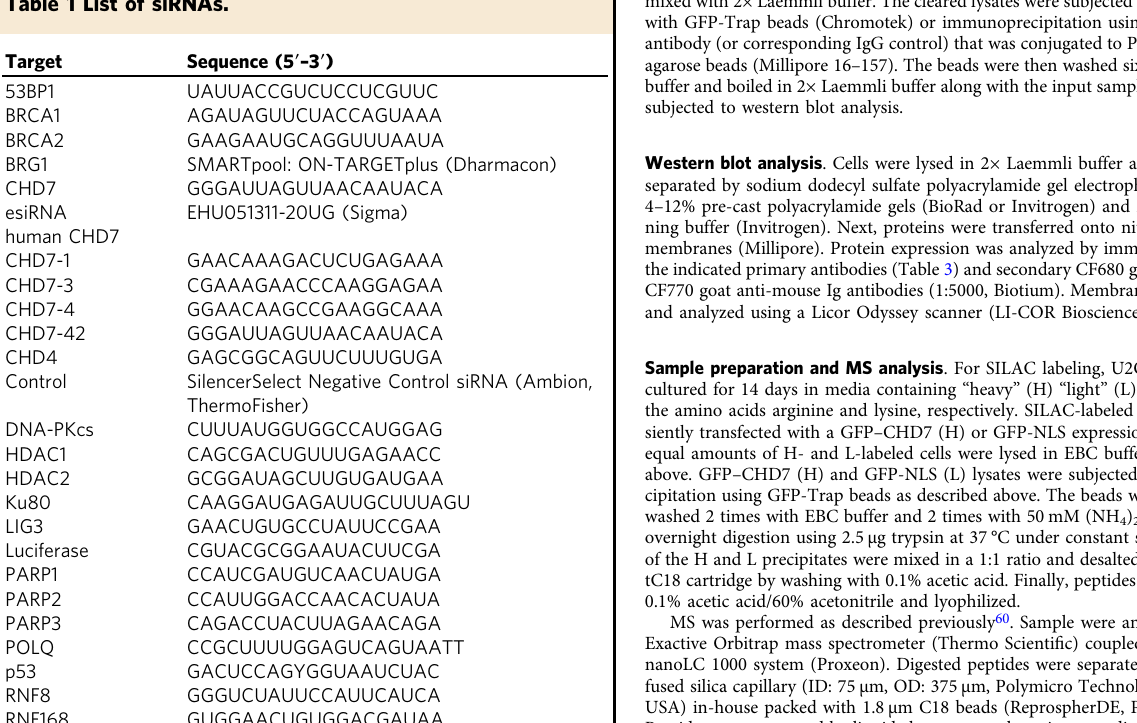
Fig. 7 CHD7-HDAC1/2 and 53BP1 synergistically affect NHEJ. a GFP-Ku70 recruitment to tracks in RPE1-hTERT cells treated for 5 min with the HDAC inhibitors TSA and SAHA before 800 nm multiphoton micro-irradiation (upper panel). The mean ± SEM from >60 cells from 2 independent experiments is shown (lower panel). b Colocalization by confocal microscopy of CHD7 and HDAC1 at 365 nm UV-A tracks 15 min after damage induction in U2OS cells (left panel). Quanti fi cation of co-localized foci is shown as mean ± SD from 31 cells acquired in at least 3 independent experiments (right panel). c As in b , except for 53BP1 and HDAC1 (left panel). Quanti fi cation of co-localized foci is shown as mean ± SD from 17 cells acquired in at least 3 independent experiments (right panel). d Mutational signatures (left panel), deletion sizes (middle panel) and microhomology usage (in case of deletion formation) (right panel) at repair junctions in the GC92 reporter for NHEJ. GC92 cells were transfected with the indicated siRNAs and I- Sce I expression vector. Repair junctions were ampli fi ed by PCR and Sanger-sequenced. The bars represent data obtained from 3 independent experiments. Statistical signi fi cance was calculated using the two-tailed Mann – Whitney U test. Statistical signi fi cance for microhomology usage was calculated for sequences showing at least 1 bp of microhomology. The junctions of the siLuc, siCHD7-1, and siCHD7-4 samples are the same as those presented in Fig. 4f. e Western blot analysis of phosphorylated RPA32 (S4/S8) and RPA32 expression in WT and CHD7 KO-2 U2OS cells transfected with the indicated siRNAs. Cells were examined 3 h after 10 Gy of ionizing radiation. Tubulin is a loading control. Representative blots from 2 independent experiments are shown. f Quanti fi cation of plasmid integration ef fi ciencies in WT and CHD7 KO-2 U2OS cells transfected with the indicated siRNAs. The mean ± SEM from 2 to 3 independent experiments is shown. Data were normalized to WT, which was set to 100%. Statistical signi fi cance was calculated using the two-tailed Student ’ s t test. g Model for how the CHD7-HDAC1/2-dependent chromatin remodeling promotes DSB repair by error-free cNHEJ. Scale bar 10 µ m. Source data are provided as a Source Data fi le.